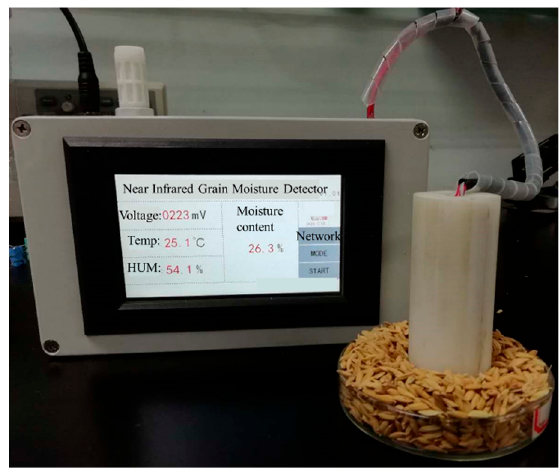
Figure 7. The detection process for test the sensor performance.